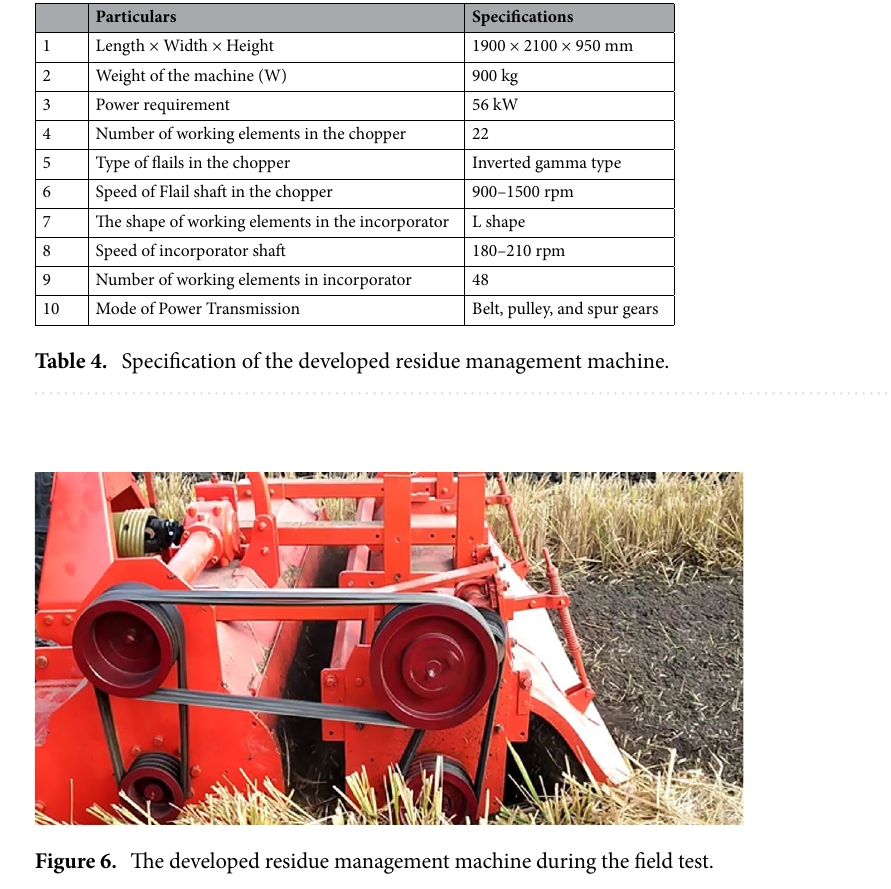
Independent Parameters meters Levels Dependent parameters Forward speed (kmph) Two levels—F 1 & F 2 (2.1 and 3.0) Shredding efficiency (%) (%)Vertical adjustment of cut (mm) Two levels—V 1 and V 2 (100 and 200) Incorporation efficiency (%) Two levels—N 1 and N 2 (900 and 1100) Size reduction of residue